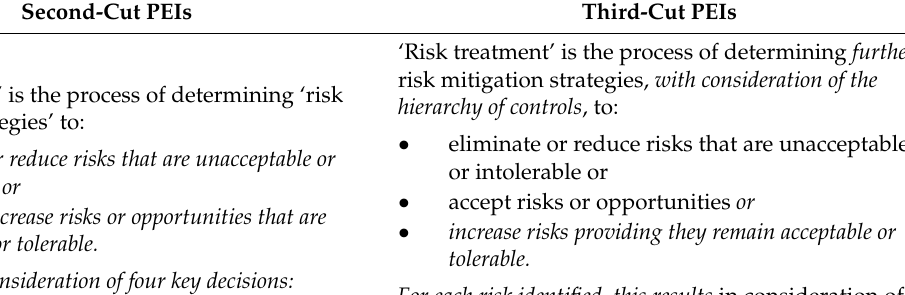
Table 2. Changes to the Risk Treatment PEI across round one (second-cut) and two (third-cut) of the